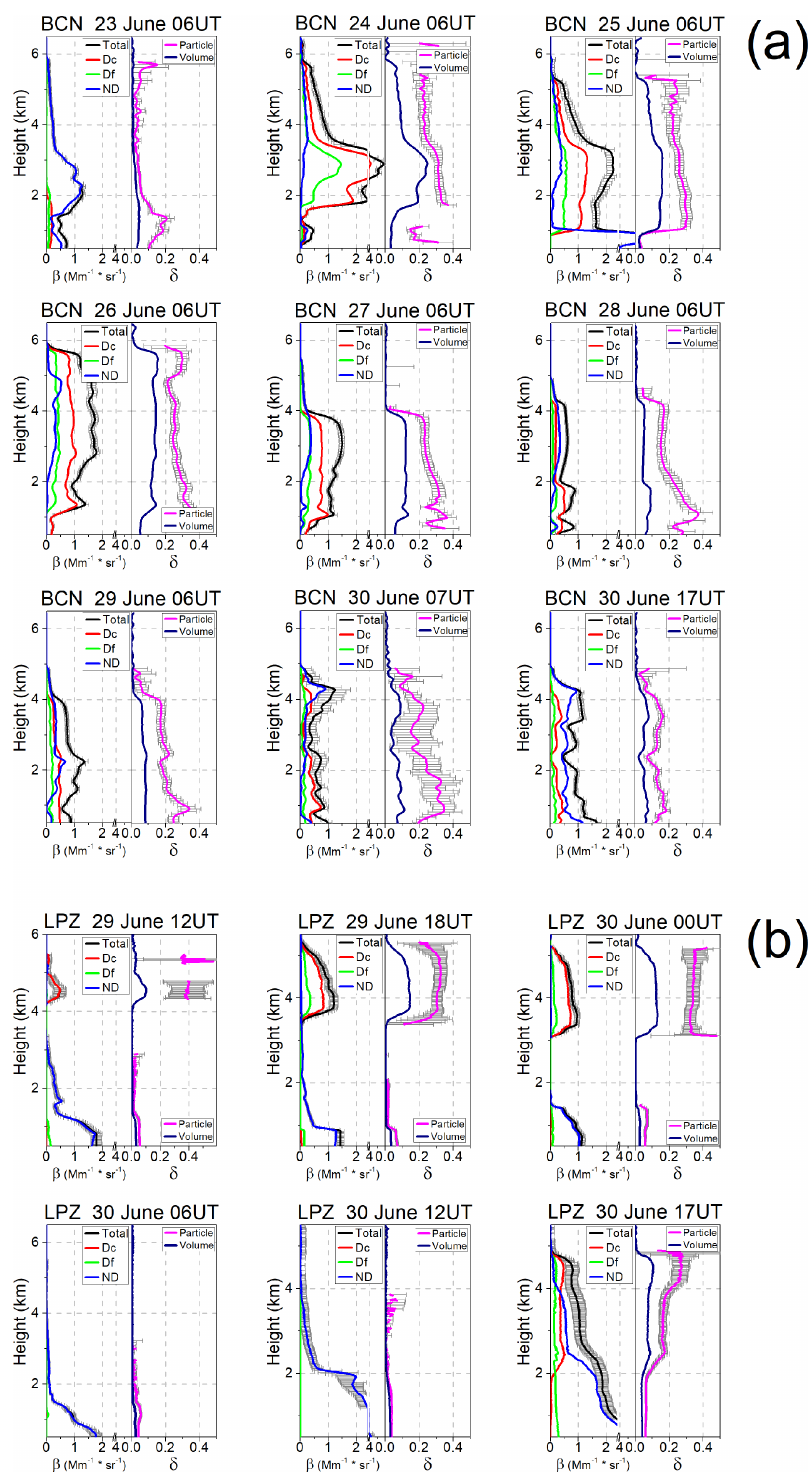
Figure 3. Vertical profiles of the optical properties for representative cases (date and time, UT stands for UTC, are shown in each panel) of the dusty events as observed at (a) BCN and (b) LPZ: the total β p (black) and those separated into dusty ( β Dc , red, and β Df , green) and non-dusty ( β ND , blue) components (left panels), together with δ V (dark blue) and δ p (magenta) (right panels). These particular cases are marked by black circles in Fig. 4. For clarity, errors (grey bars) are shown only for β p and δ p (particular uncertainties are in Table